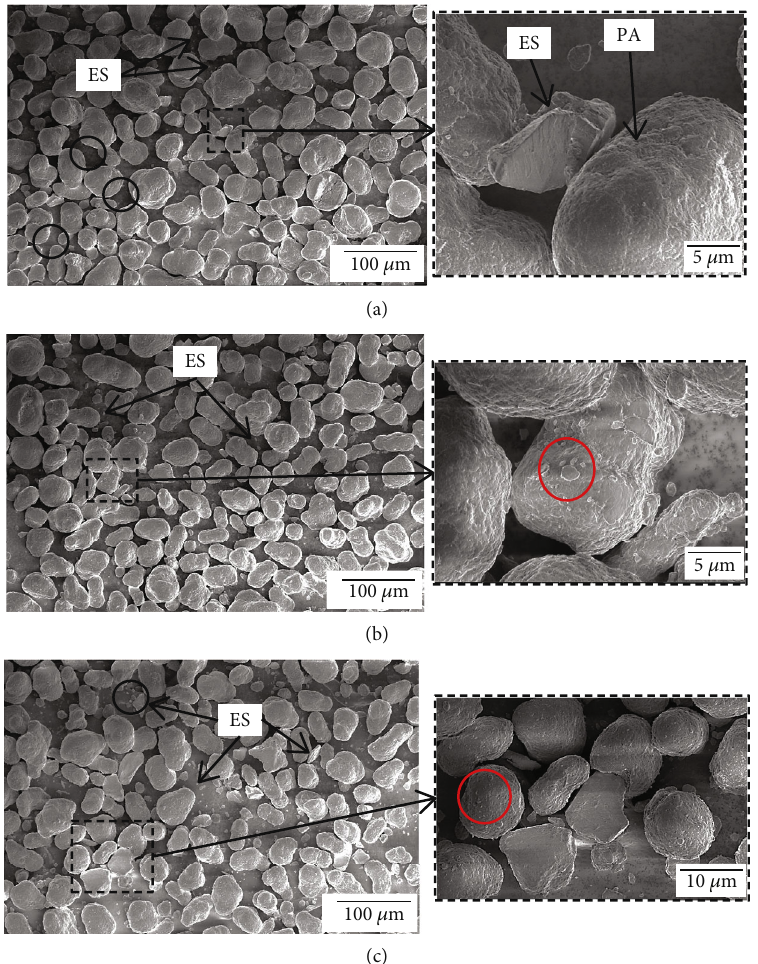
Figure 3: SEM images of PA/ES composite powders: (a) PA3 (the insert image shows the surface morphology of ES and PA particles); (b) PA5; and (c) PA10 (the insert image shows the physical interaction between ES and PA particles). Circles in (a) show less particle distribution of ES within the matrix. Circles in (c) show some agglomerated ES within the matrix. Circles in the insert micrographs of (b) and (c) show the fi ne ES were dispersed and distributed on the surface of a PA